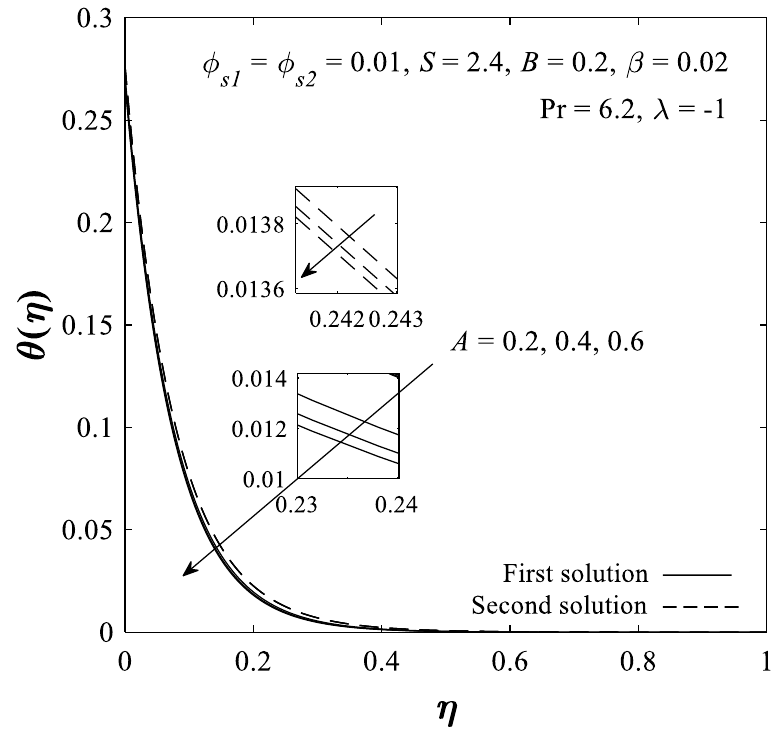
Figure 10. Velocity profile